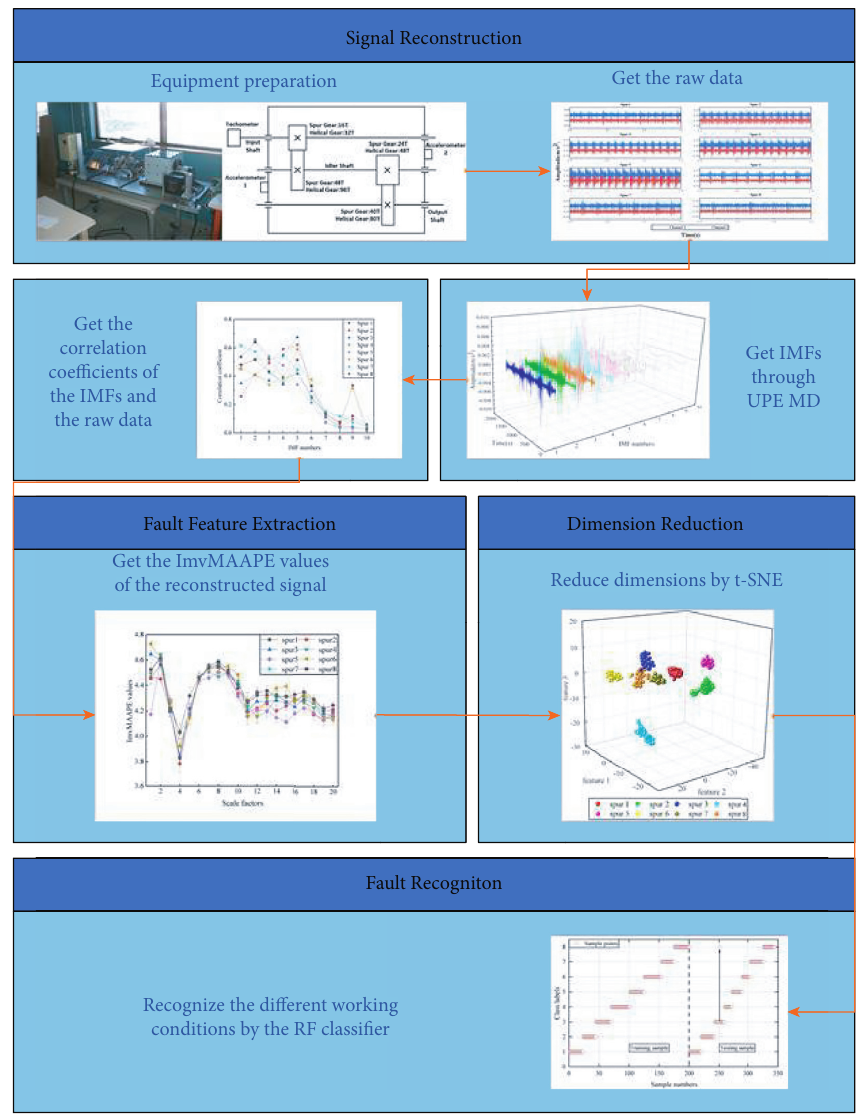
Figure 3: The flow chart of the proposed